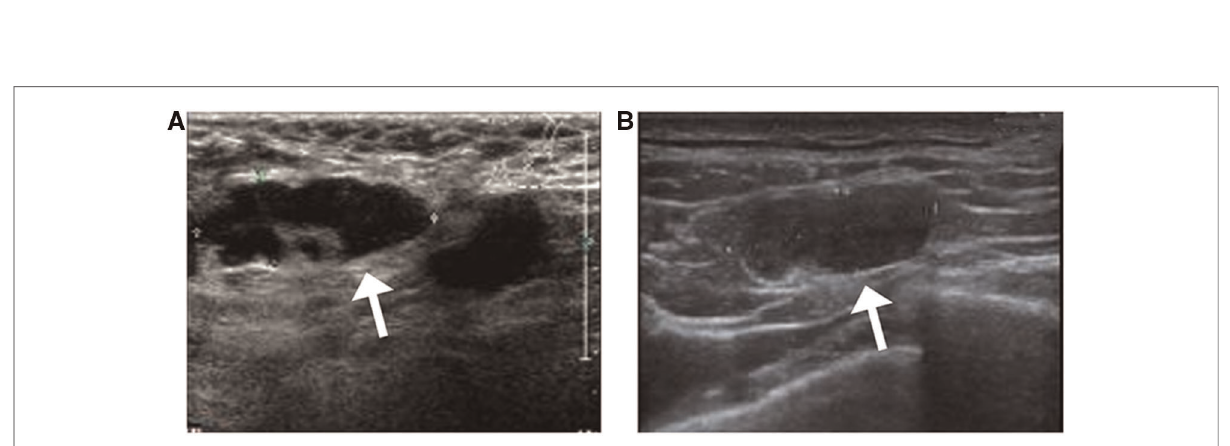
FIGURE 6 Sonographic fi ndings from a 53-year-old patient with invasive ductal carcinoma with micropapillary features ( A ) axillary sonography showing multiple hypoechoic nodules in the affected axilla, the largest of which is approximately 2.9 cm×1.1 cm in size, with poorly de fi ned and irregular borders and poorly delineated corticomedullary structures (white arrow) ( B ) multiple hypoechoic nodules are visible in the left supraclavicular fossa, the largest of which measures approximately 1.8 cm×0.6 cm in size, with poorly de fi ned corticomedullary structures (white